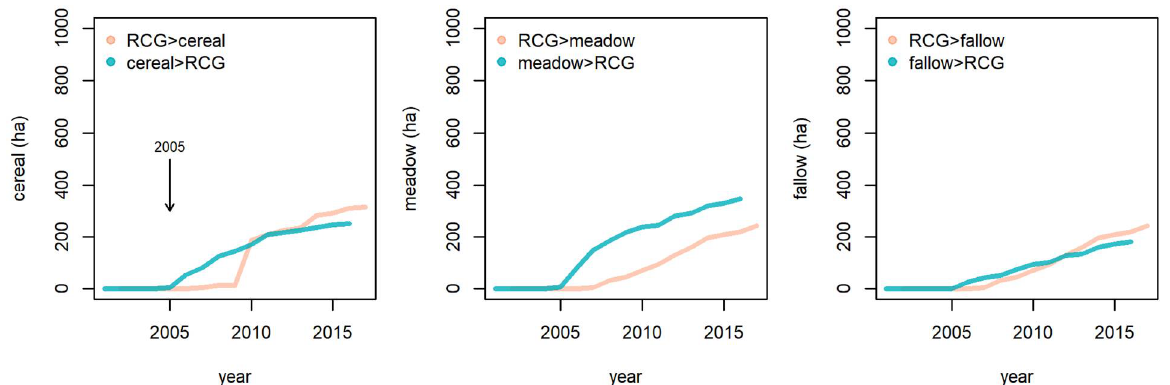
Figure 6. Changes in land use related to reed canary grass (RCG) used for energy in Sweden. The line cereal > RGC refers to the area with cereal replaced by RCG, and RCG > cereal refers to plantations being abandoned and replaced by cereal fields and likewise for meadow and fallow land.